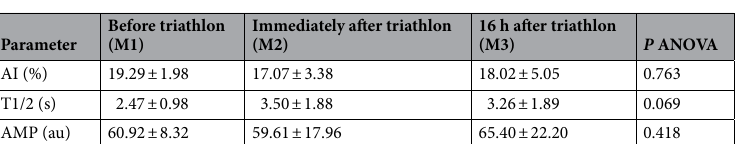
16 h after triathlon (M3) P ANOVA